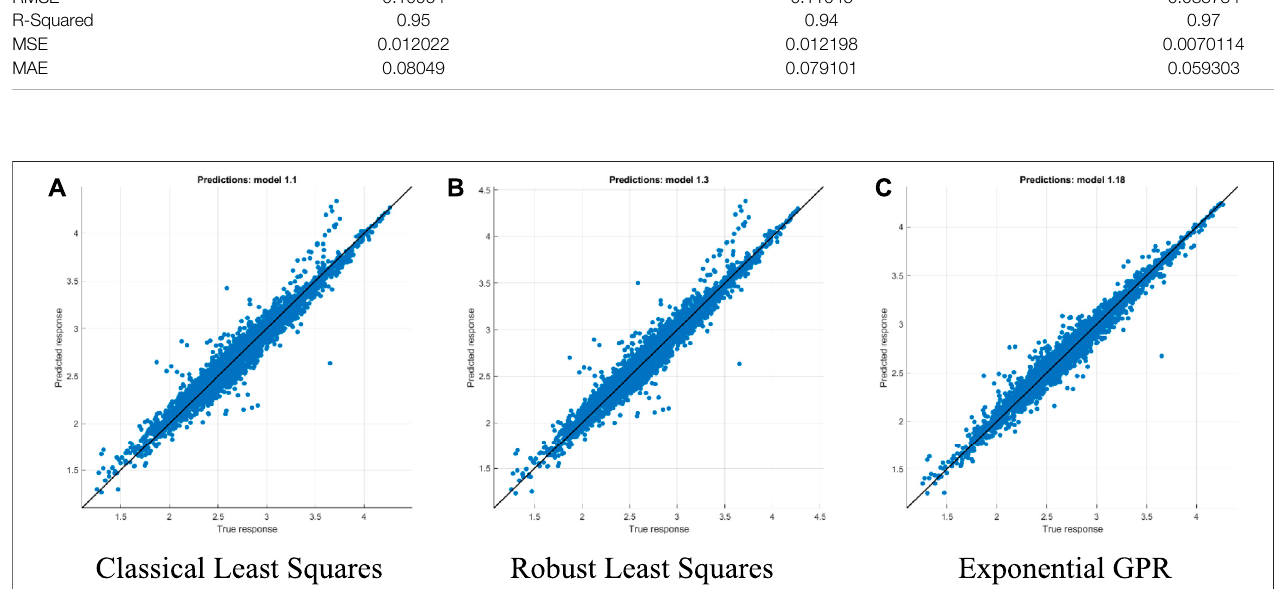
FIGURE1| ComparisonofactualvalueandpredictionofCO 2 emissionsbetweentheselectedmodels. (A) ClassicalLeastSquares. (B) RobustLeastSquares. (C) Exponential GPR. Notes: 1) The horizontal axis represents actual CO 2 emissions in logarithm, and the vertical axis represents predicted CO 2 emissions in logarithm. 2) CO 2 emissions are measured in ten thousand tons of standard